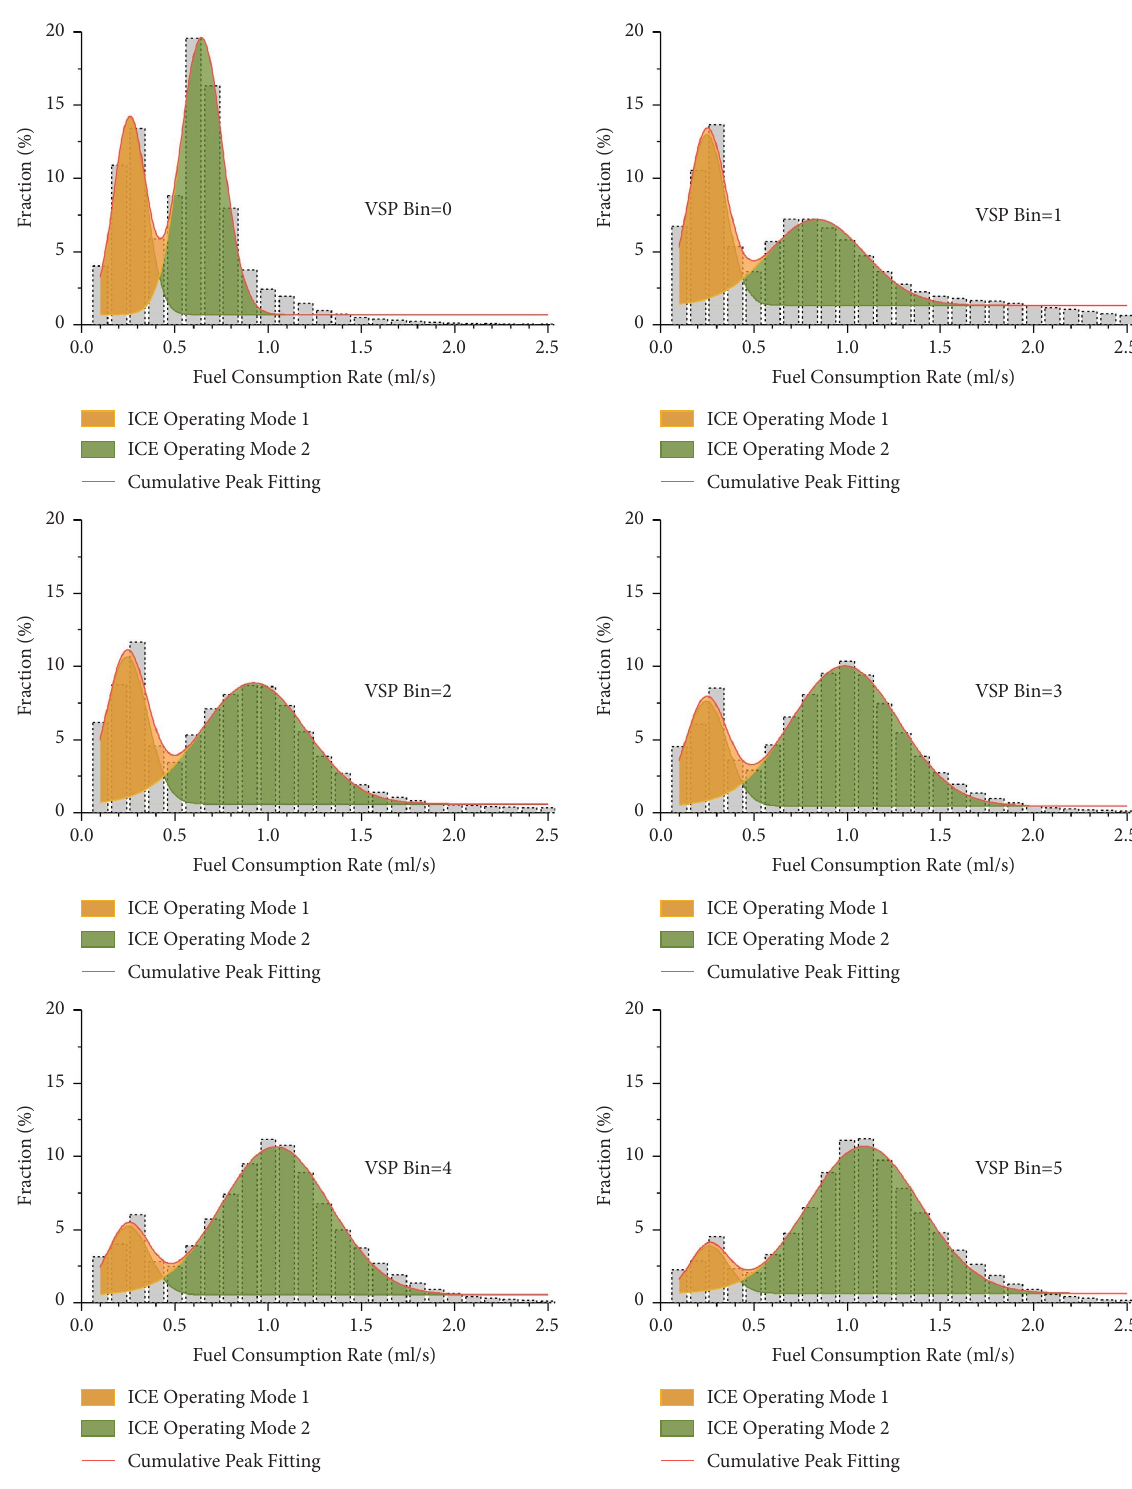
Figure 6: Distribution of HEV fuel consumption rates in each VSP